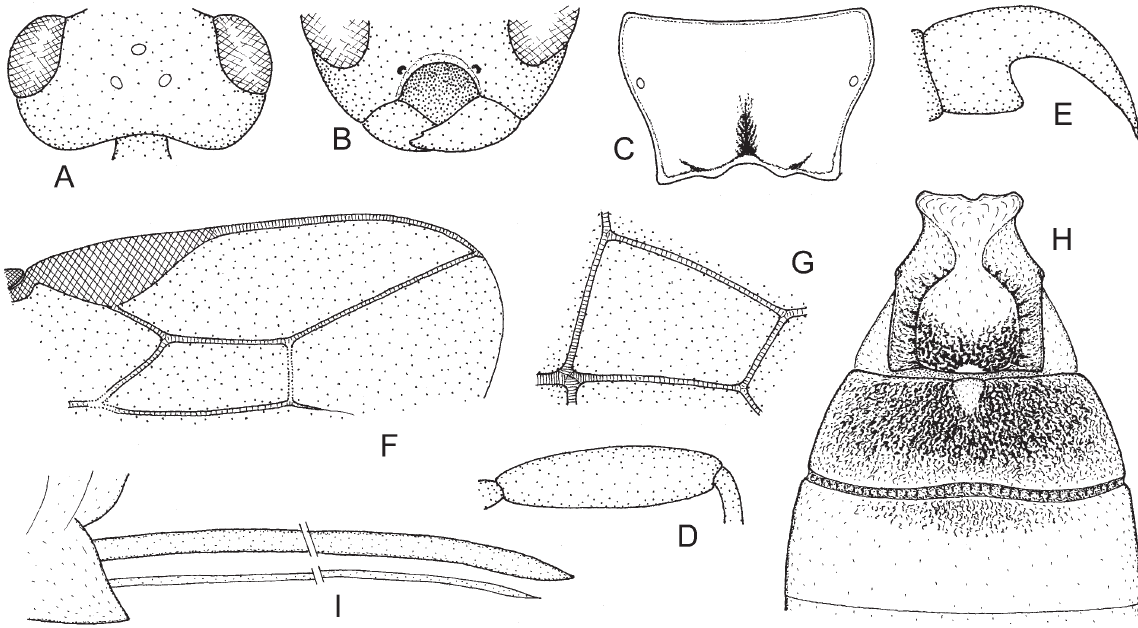
Fig. 63. Bracon ( Glabrobracon ) immutator Nees, 1834, ♀ neotype. A . Head in dorsal view. B . Head in frontal view. C . Propodeum. D . Hind femur. E . Claw. F . Distal part of right forewing. G . First discal cell of right forewing. H . Tergites 1-3. I . Hind end of ♀